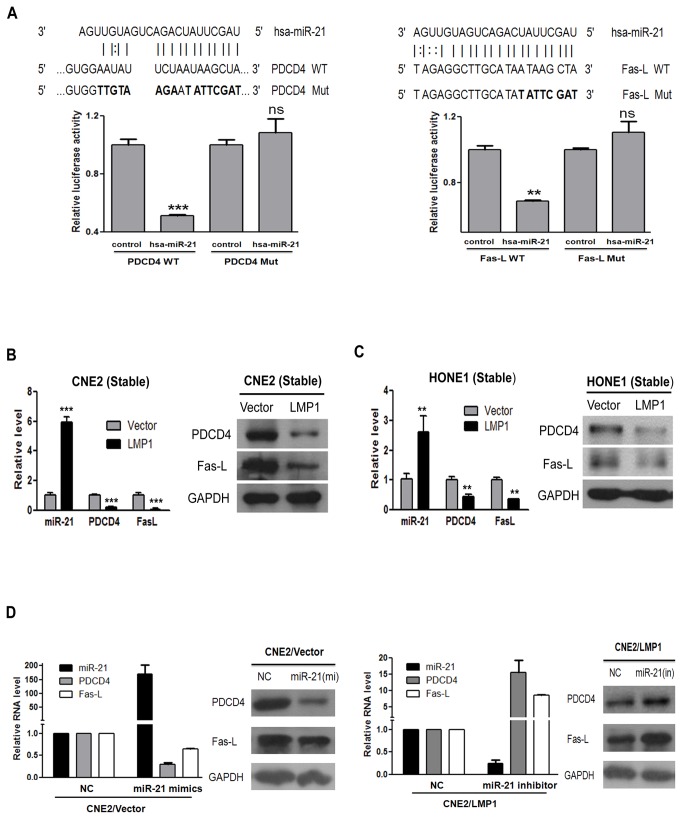
The antiapoptoic effect of miR-21 is through downregulation of PDCD4 and Fas-L.(A) Sequence alignment between miR-21 and the 3’UTR of human PDCD4 or Fas-L mRNA. Boldfaced letters indicate the seed-mutated region. Luciferase reporter assays show the effect of miR-21 on the activity of the PDCD4 3’UTR or Fas-L 3’UTR reporters. Co-transfection was performed in 293T cells using plasmids, including human PDCD4 3’UTR (PDCD4 WT), Fas-L 3’UTR (Fas-L WT), the miR-21_binding site-mutated (Mut) PDCD4 3’UTR (PDCD4 Mut), the miR-21_binding site-mutated (Mut) Fas-L 3’UTR (Fas-L Mut), and a miR-21 expression plasmid (pLMP-miR-21). Empty pLMP plasmid was used as a negative control. The values in negative control treated cells were all set to 1 (ns, not significant; ** P < 0.01; *** P < 0.001 vs negative control treated cells). (B, C) The levels of miR-21, PDCD4 and Fas-L in CNE2 (B) and HONE1 (C) stable cell lines. The left and right panels show the mRNA and protein levels, respectively. mRNA levels were normalized with GAPDH mRNA levels, and the miRNA level was normalized to that of U6. The values in vector control treated cells were all set to 1 (** P < 0.01; *** P < 0.001 vs vector control treated cells). (D) CNE2 stable cell lines were transfected with 50 nM miR-21 inhibitor (right panels), miR-21 mimics (left panels) or negative controls (NC) and then harvested after 72 h to detect the expression of miR-21, PDCD4 and Fas-L by qRT-PCR and immunoblotting. The fold changes were relative to negative controls, which were set as 1.